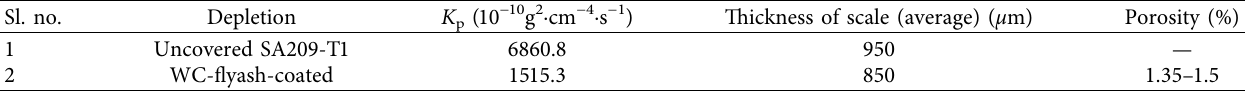
Table 2: Thickness of scale (average) and porosity of coverings. Sl. no.